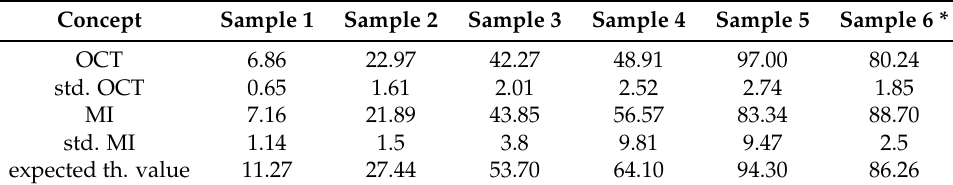
Table 1. Comparison between optical coherence tomography measurement, magnetic inductive (MI) measurement, and the expected theoretical values. The sprayed sample is marked with an *. All thickness values are given in µ m.